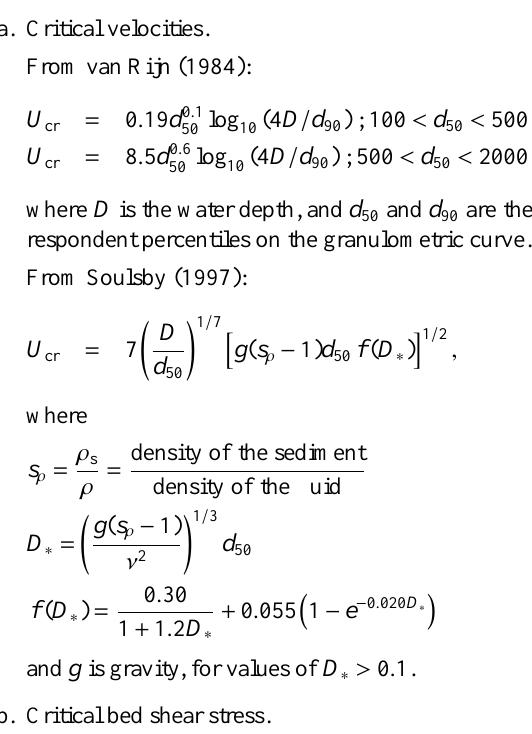
Figure 1. Species represented in the study. Black mangrove roots (left) and European fan worm (right). Pictures obtained from the USDA-NRCS and MESA websites,